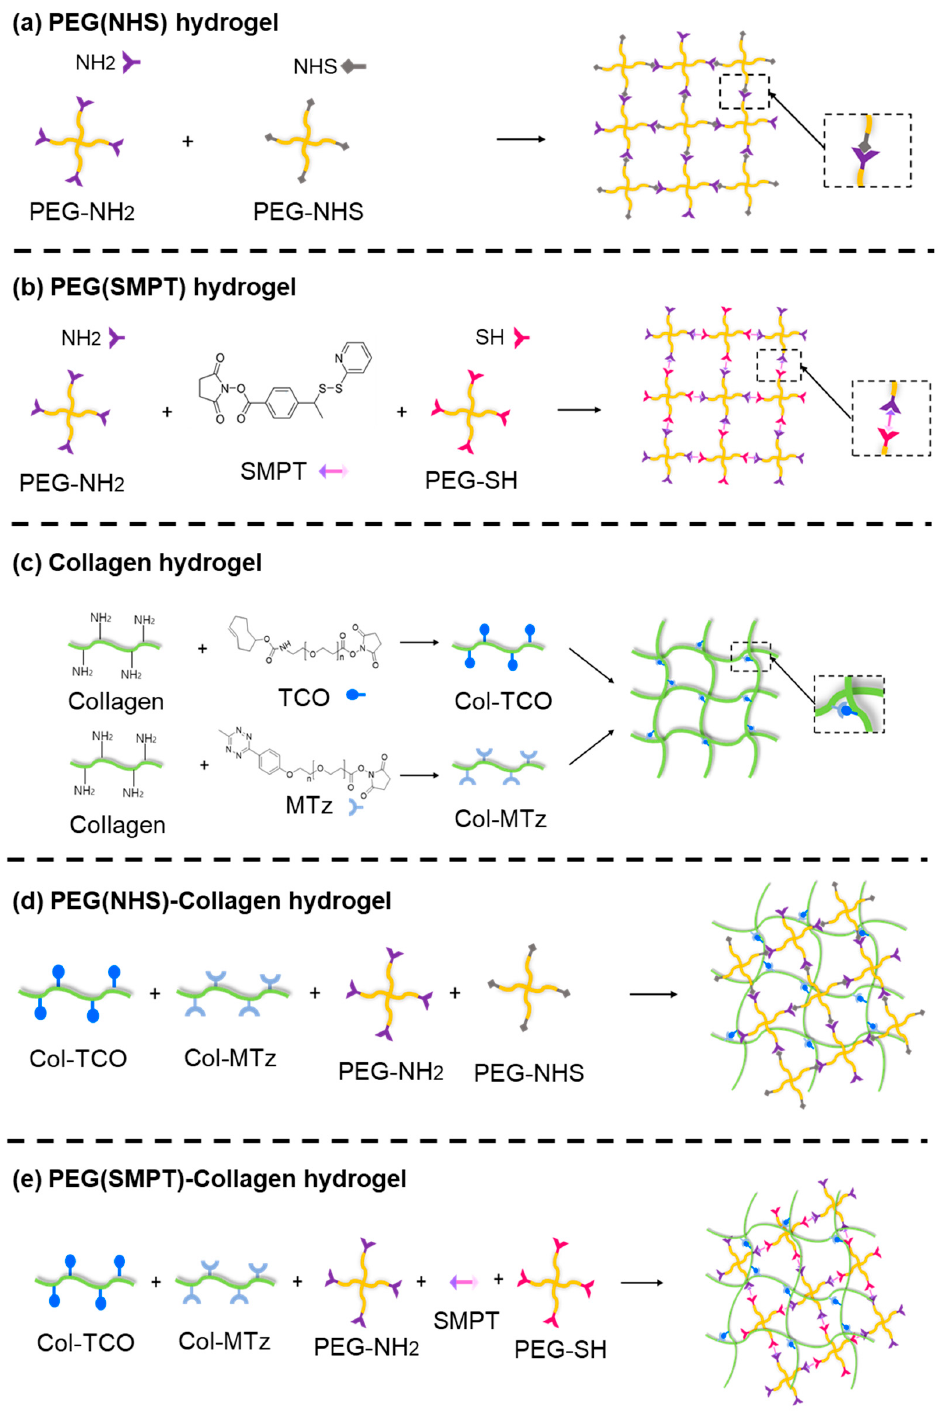
Figure 1. Schematic representation of chemical conjugation that constitutes each type of hydrogels: ( a ) PEG (NHS), ( b ) PEG (SMPT), ( c ) Collagen, ( d ) PEG (NHS)-Collagen, and ( e ) PEG (SMPT)-Colla- gen hydrogels. Collagen